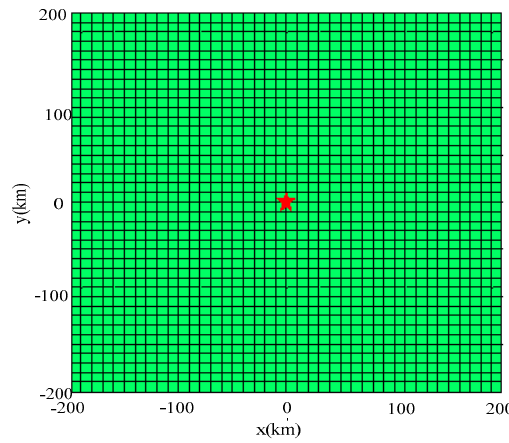
Figure 1. The monitoring domain.